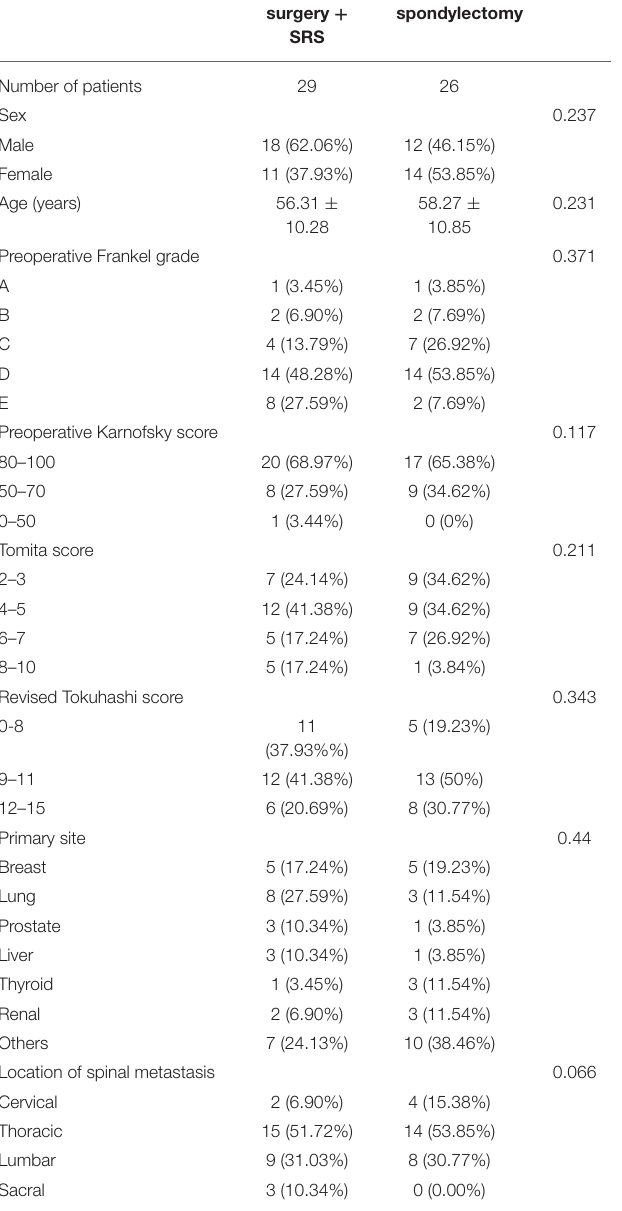
Separation surgery +